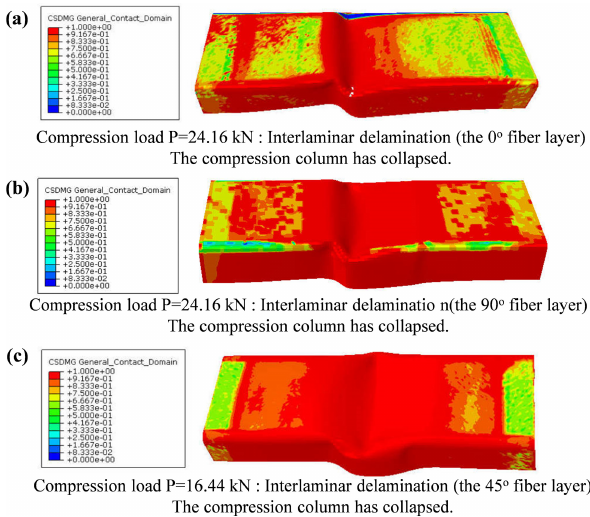
Figure 17: Interlaminar delamination failure area distribution of compression columns at the final failure state: (a) DCYG-A: 0 ∘ fiber layer, (b) DCYG-A: 90 ∘ fiber layer, and (c) DCYG-B: 45 ∘ fiber